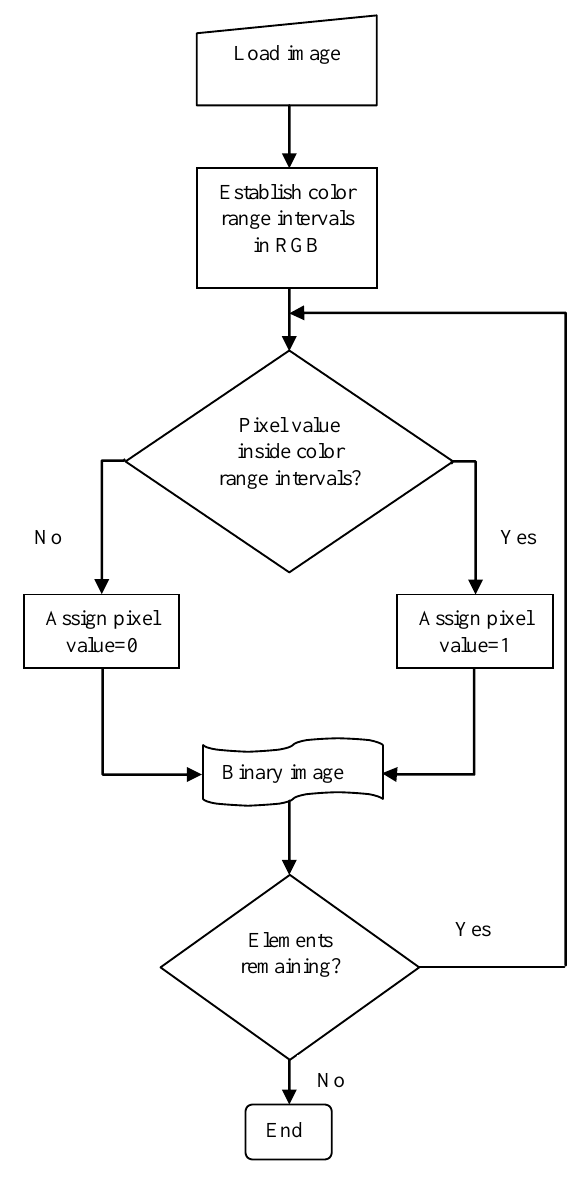
Figure 3. Flow Chart of the image processing